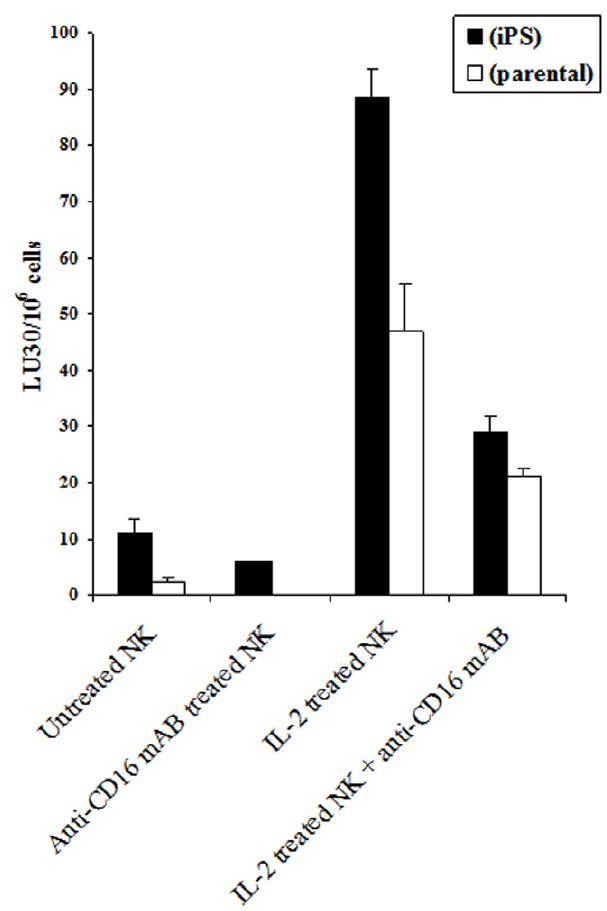
Figure 8. hiPSCs are more susceptible to NK cell mediated cytotoxicity than their parental line. NK cells (1 6 10 6 /ml) were left untreated or treated with IL-2 (1000 units/ml), or anti-CD16 mAb (3 m g/ ml) or a combination of IL-2 (1000 units/ml) and anti-CD16 mAb (3 m g/ ml) for 12–24 hours before they were added to 51 Cr labeled hiPSCs or 51 Cr labeled parental cells from which the hiPSCs were derived, and NK cell cytotoxicities were determined using a standard 4 hour 51 Cr release assay and the lytic units 30/10 6 cells were determined using inverse number of NK cells required to lyse 30% of the hiPSCs or parental cells 6 100. One of two representative experiments is shown in this